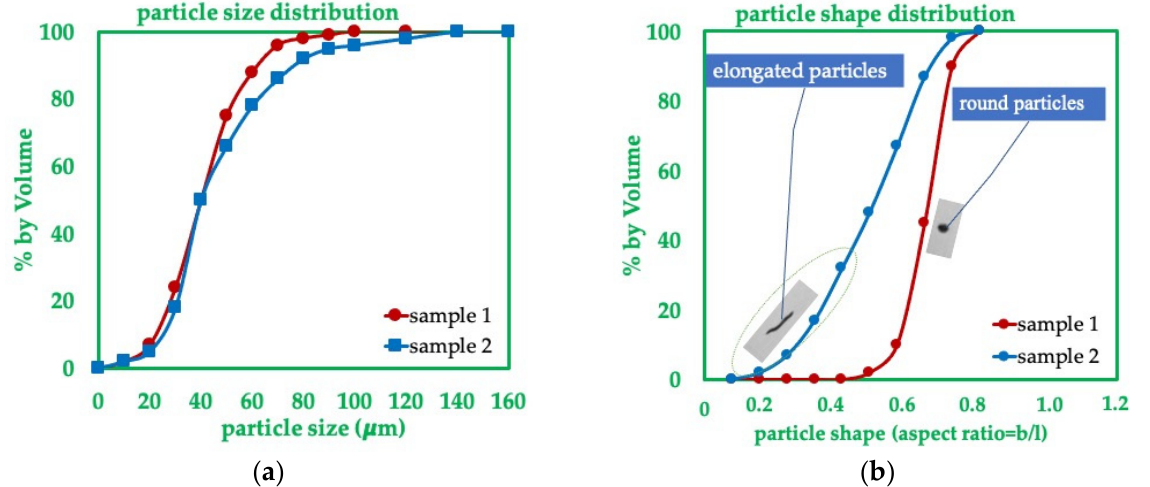
Figure 5. Two different starch samples have ( a ) similar d 50 sizes but ( b ) different aspect ratios (modified from [37,38]).